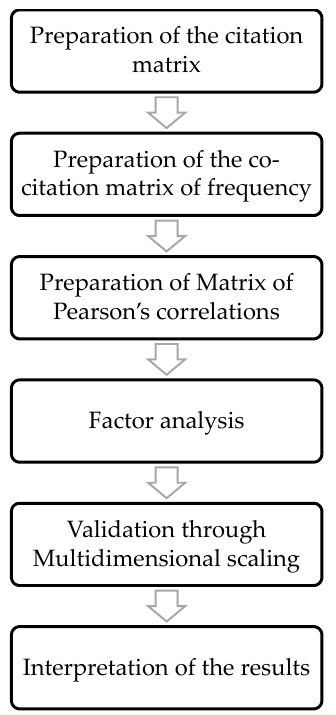
Figure 1. Flow chart of the development of the co-citation analysis.